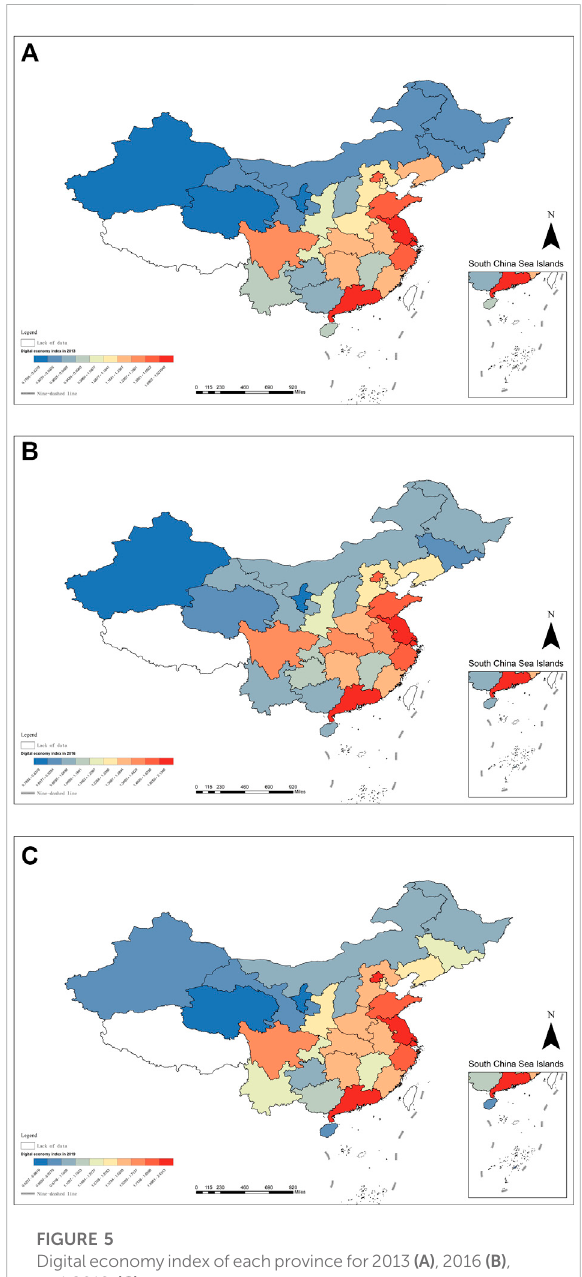
FIGURE 5 Digitaleconomyindexofeachprovincefor2013 (A) ,2016 (B) , and 2019 (C)